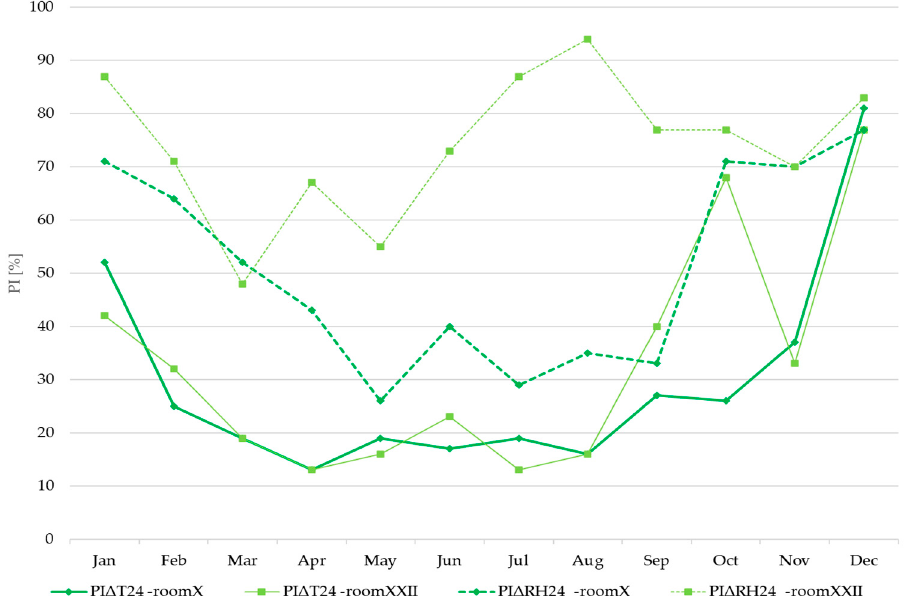
Figure 19. PI monthly values of hygrothermal parameters daily variation for room X and XXII.